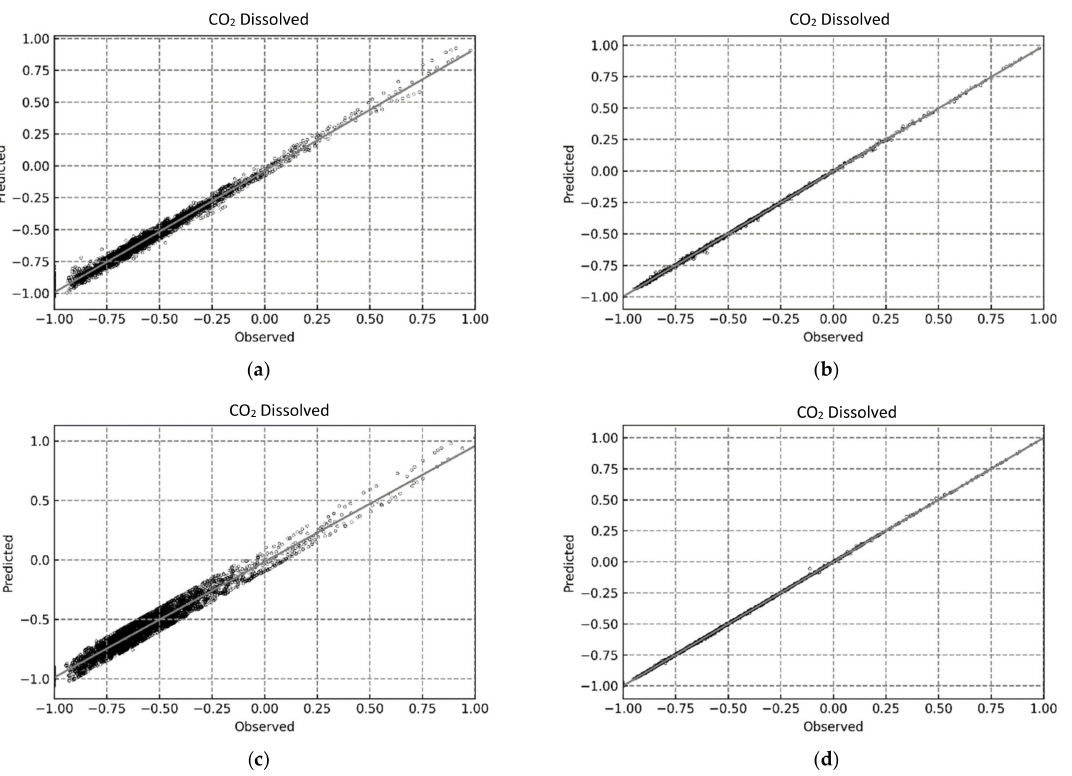
Figure 12. Predicted vs. Observed plots for determining CO 2 dissolved using the proposed ML-based models. ( a ) MLP; ( b ) RF; ( c ) SVR; ( d ) XGB.